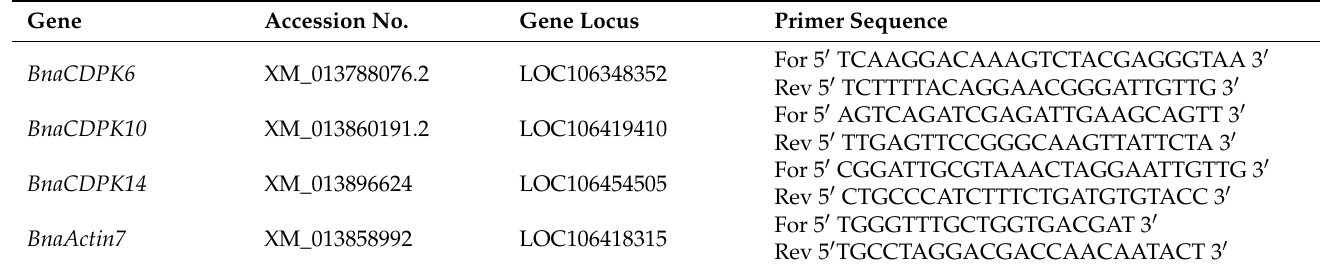
Table 1. Primers used in this